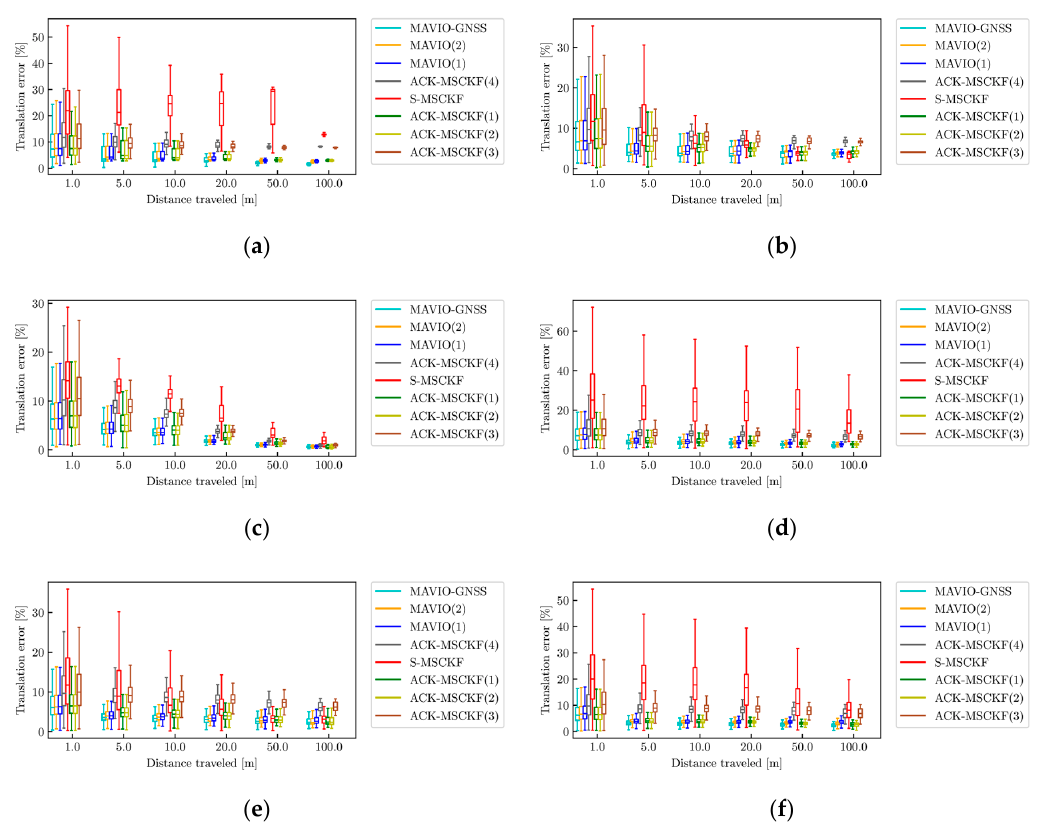
Figure 12. The relative translation error percentages (RTEPs) for MAVIO, MAVIO-GNSS, ACK-MSCKF and S-MSCKF for the datasets: ( a ) VD01; ( b ) VD02; ( c ) VD03; ( d ) VD04; ( e ) VD05; ( f ) VD06.